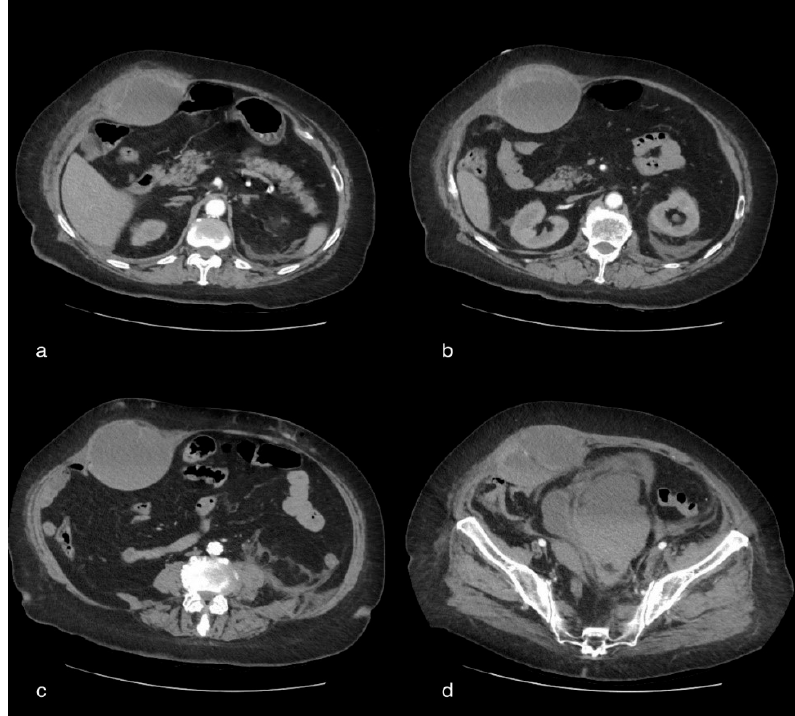
Figure 3. A 75-year-old female patient with volumetric increase in the rectus muscle of the right abdomen of approximately hypo/hyperdense inhomogeneous densitometry due to hematoma. The pelvic cavity appears to be occupied by a voluminous fluid/overfluid collection spontaneously hyperdense in its more declivity.